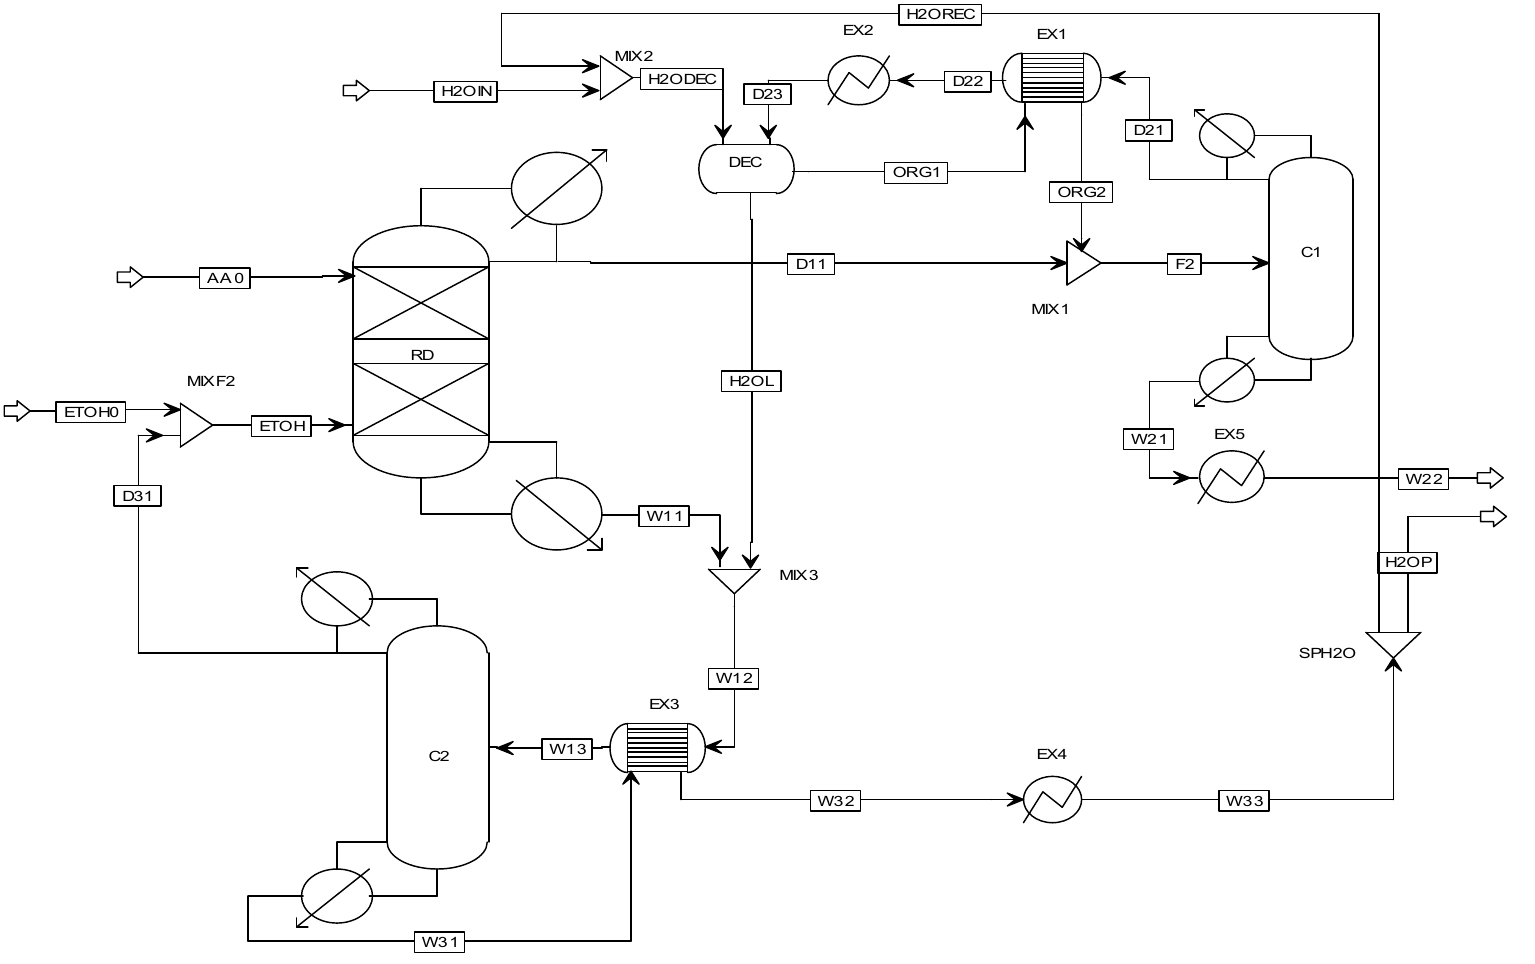
Figure 2. Ethyl acetate production via reactive distillation column with a separation unit.